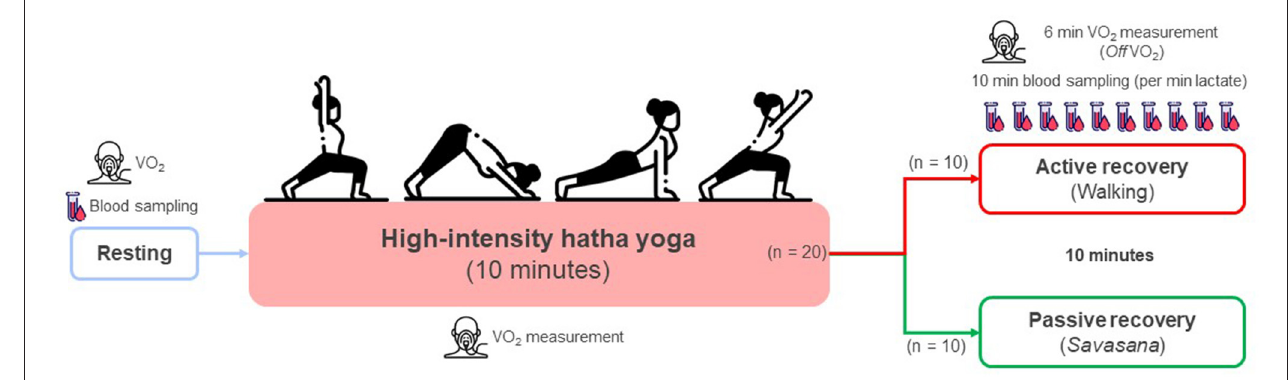
20) and were randomly separated into active (walking; n =